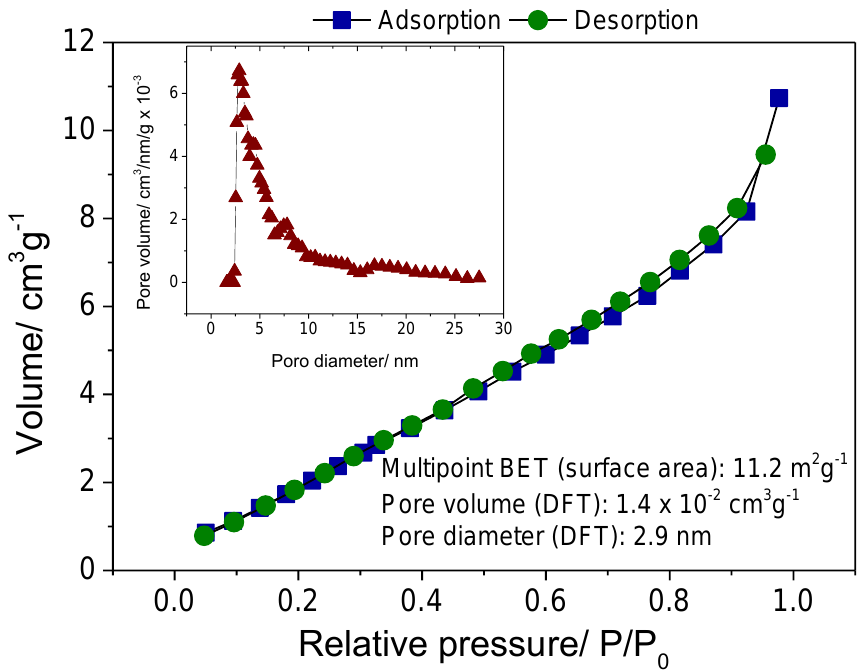
Figure 3. Texture properties of Sn 1.5 PMo 12 O 40 catalyst: N 2 adsorption and desorption curves and pores diameter distribution curve. Table 2. Texture properties of H 3 PMo 12 O 40 and Sn 1.5 PMo 12 O 40 salt.